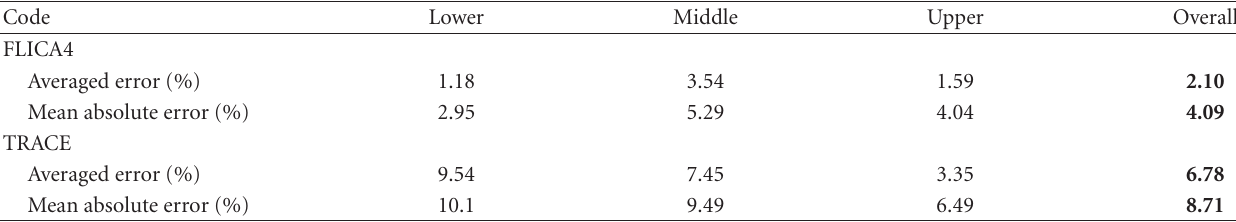
Table 6: Mean absolute error of void fraction.